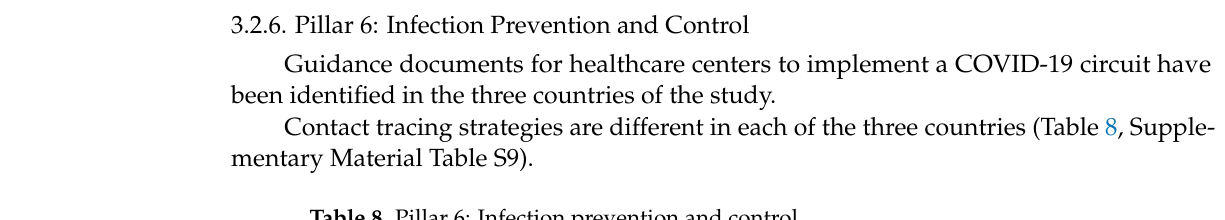
Table 8. Pillar 6: Infection prevention and control.